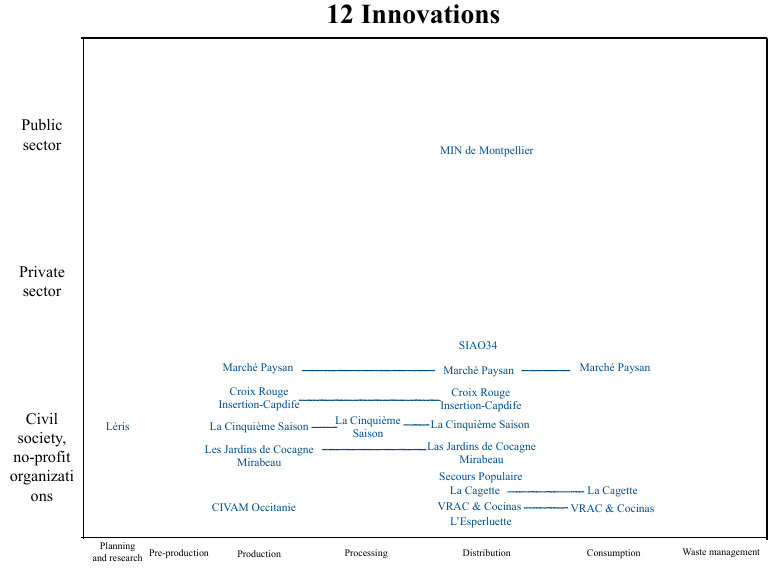
Figure 3. The innovations chosen.